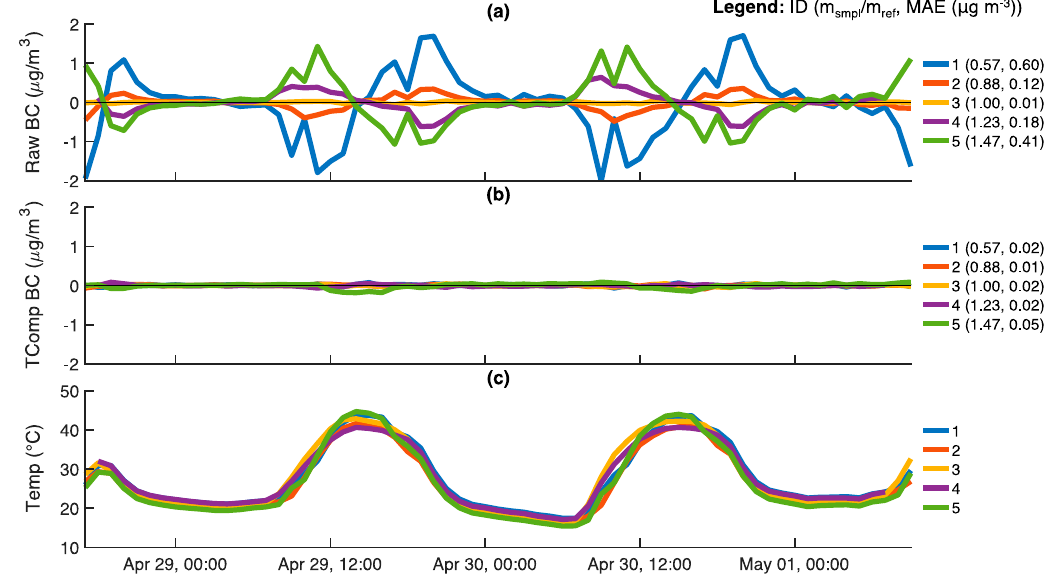
Figure 7. The response of five ABCD units operating outdoors with HEPA filters on the air inlets: ( a ) Uncompensated black carbon (BC) concentrations; ( b ) Temperature-compensated BC concentrations; ( c ) Optical cell temperatures. All data is provided on a 60-min time base. For each ABCD, the slope ratio of the optical cell and mean absolute error (MAE) of BC concentration measurements are shown in the legends. The MAE of BC measurements is evaluated relative to the desired zero response (0 μ g m − 3 ).